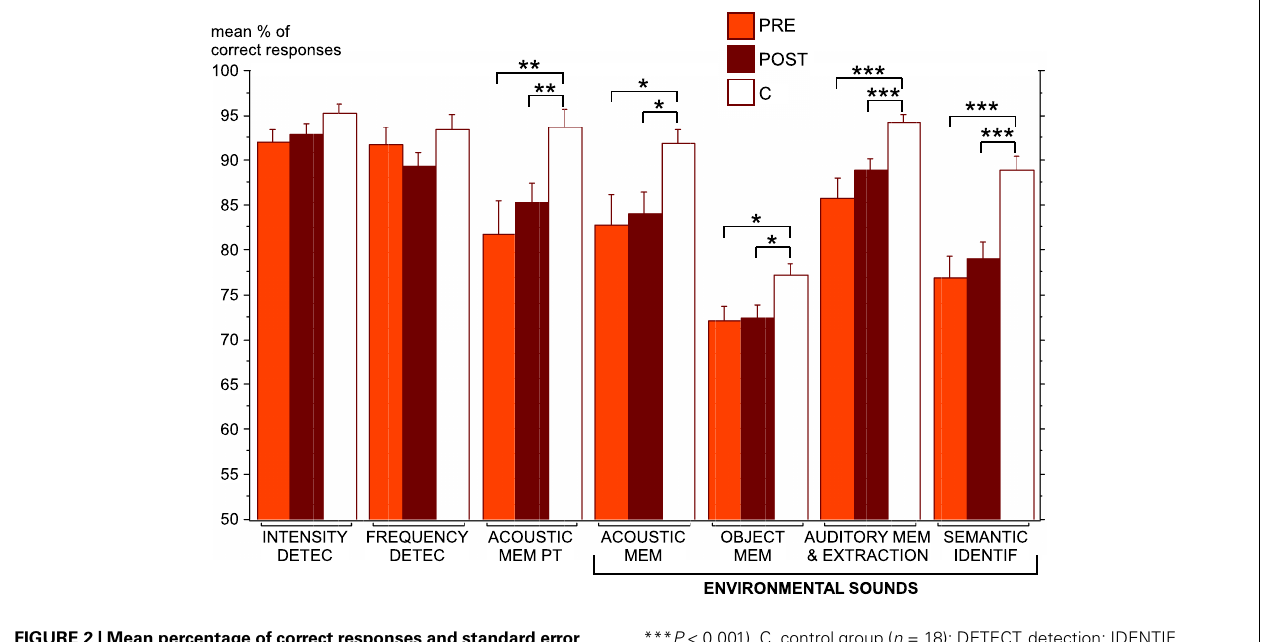
*** P < 0.001). C, control group ( n = 18); DETECT, detection; IDENTIF, identifi cation; MEM, short-term memorization; PT, pure tones; PRE,